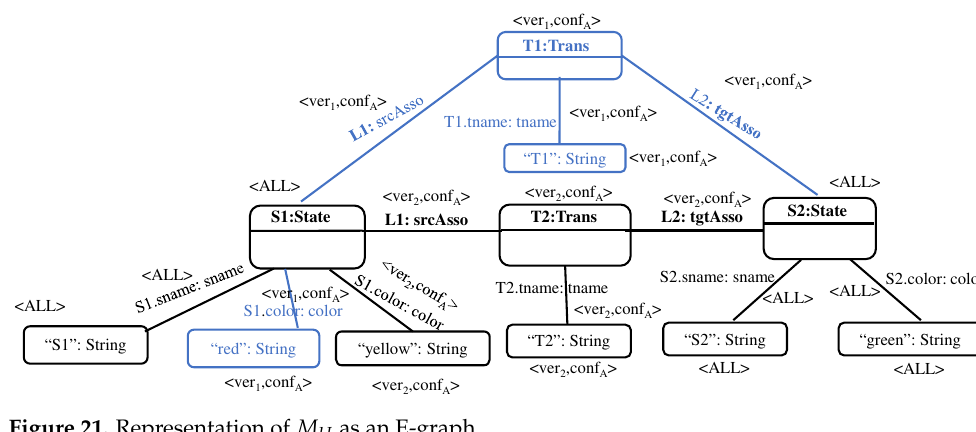
Figure 21. Representation of M U as an E-graph.